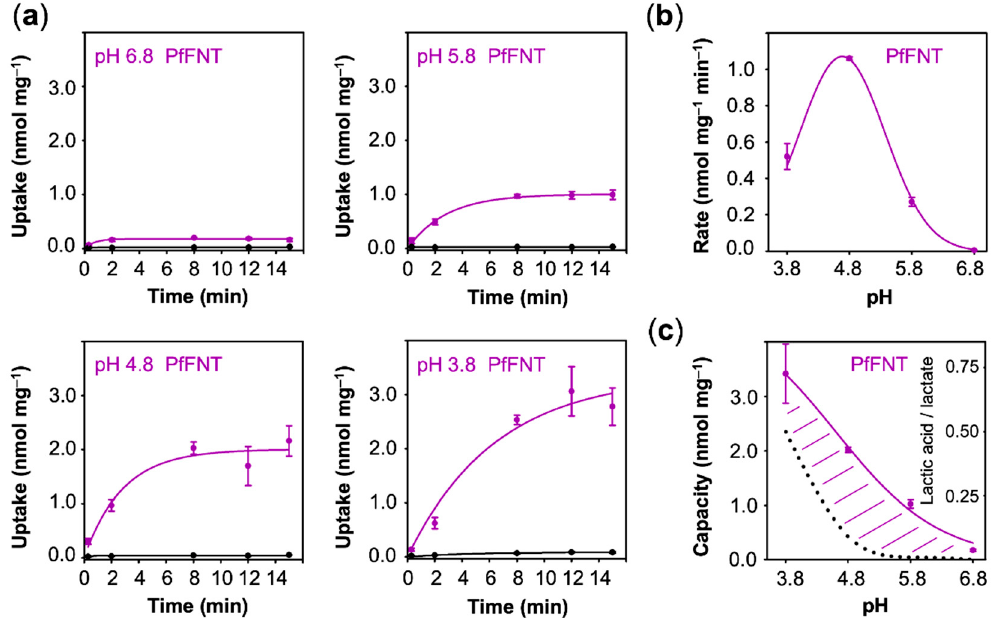
Figure 5. pH-dependent uptake of lactate/lactic acid into PfFNT expressing yeast. ( a ) Shown are uptake curves over time using cells with PfFNT (purple) compared to non-expressing cells (black). ( b ) Uptake rates derived from the uptake curves. ( c ) Uptake capacity obtained from the plateaus of the uptake curves. The dotted line indicates the proportion of neutral lactic acid at a given pH condition. Error bars indicate SEM from three independent experiments.